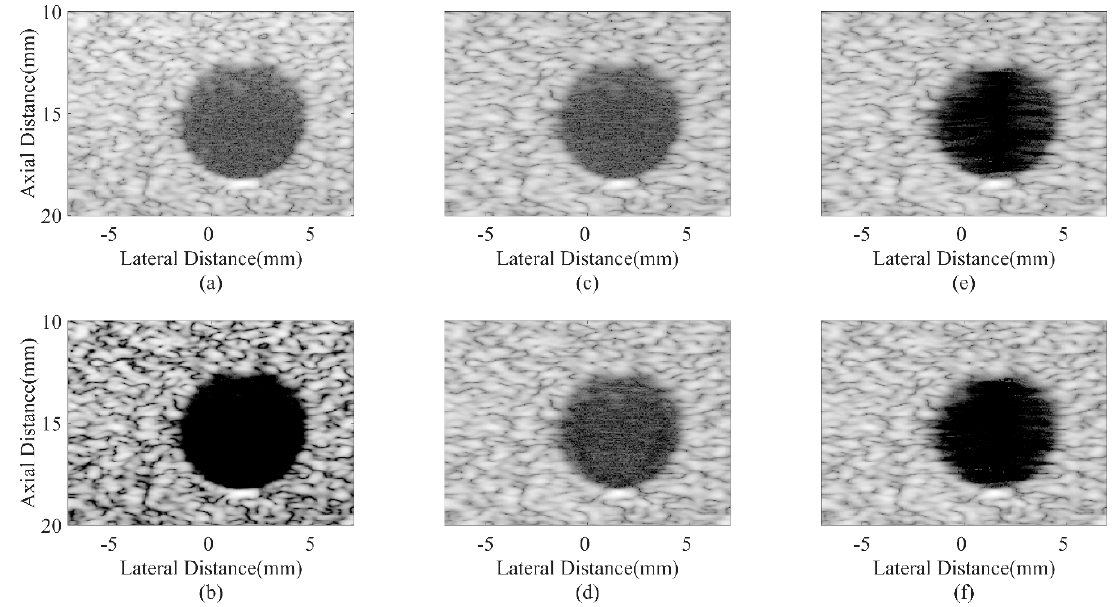
Figure 7. Experimental anechoic cyst phantom using different beamformers: ( a ) DAS, ( b ) CF, ( c ) JTR-MV, ( d ) JTR-MV GCF, ( e ) JTR-ESBMV, ( f ) JTR-ESBMV GCF. All images are shown with a dynamic range of 60 dB. Table 5. CR and CNR for experimental anechoic cysts.